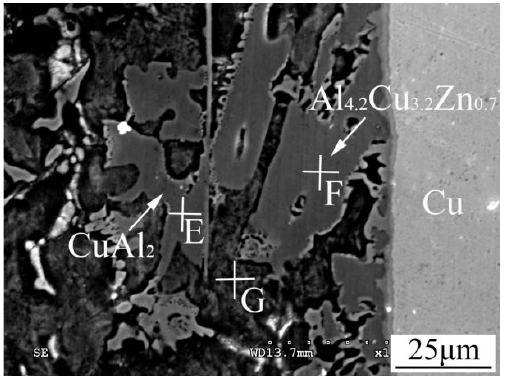
Figure 14. SEM image of brazing seam/Cu interfaces of 1035 Al/Cu joint brazed by Zn-15Al. Table 4. EDS results of chemical compositions (at. %) of points marked in Figure 14.